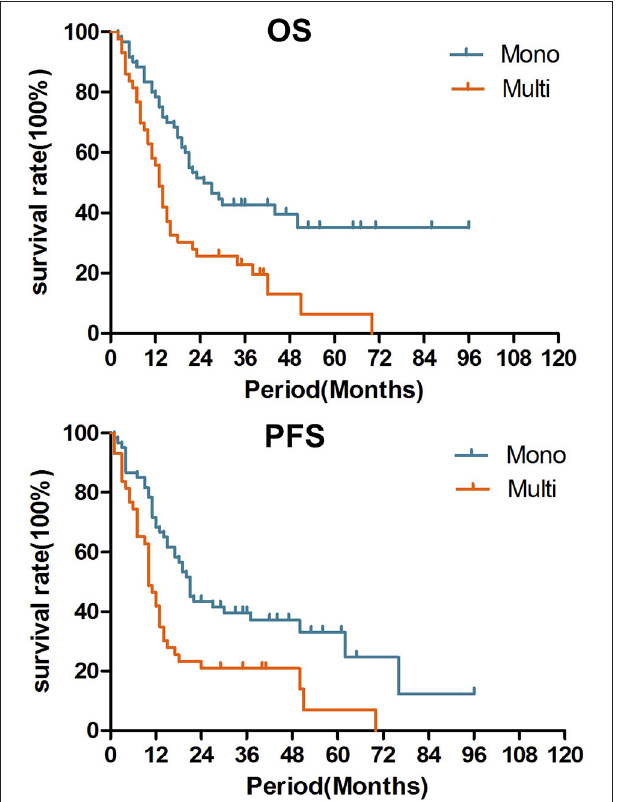
FIGURE 1 | Over survival and Progression free survival after salvage radiotherapy for single recurrent lymph node and multiple lymph nodes ( p = 0.001, 0.008).